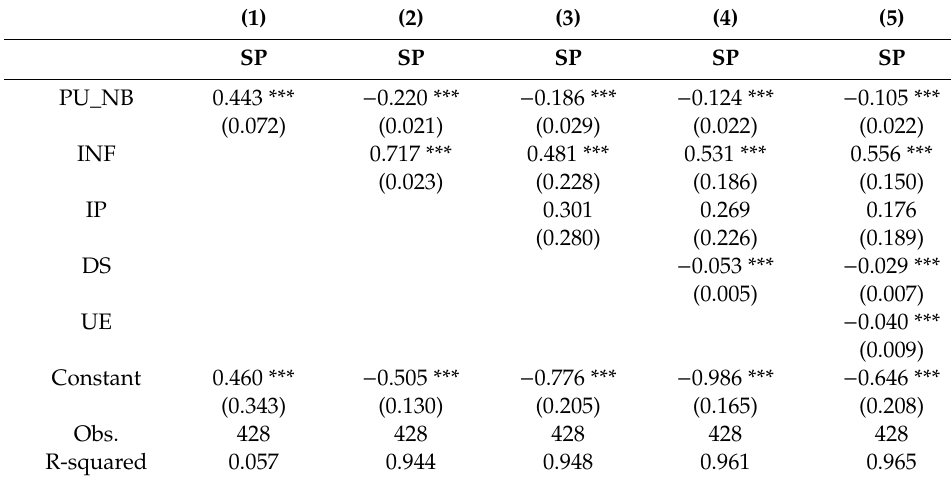
Table A1. OLS baseline results.